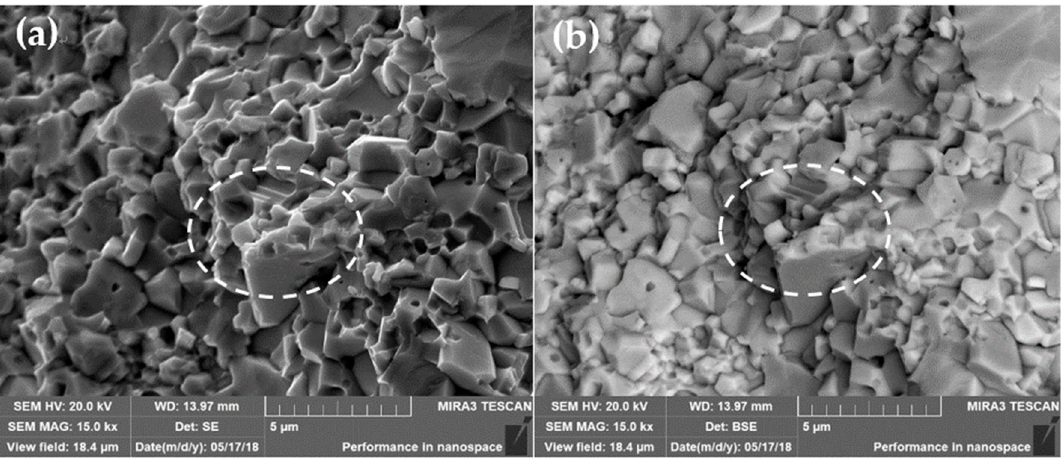
Figure 8. ( a ) Secondary electron image; ( b ) backscattered electron image.